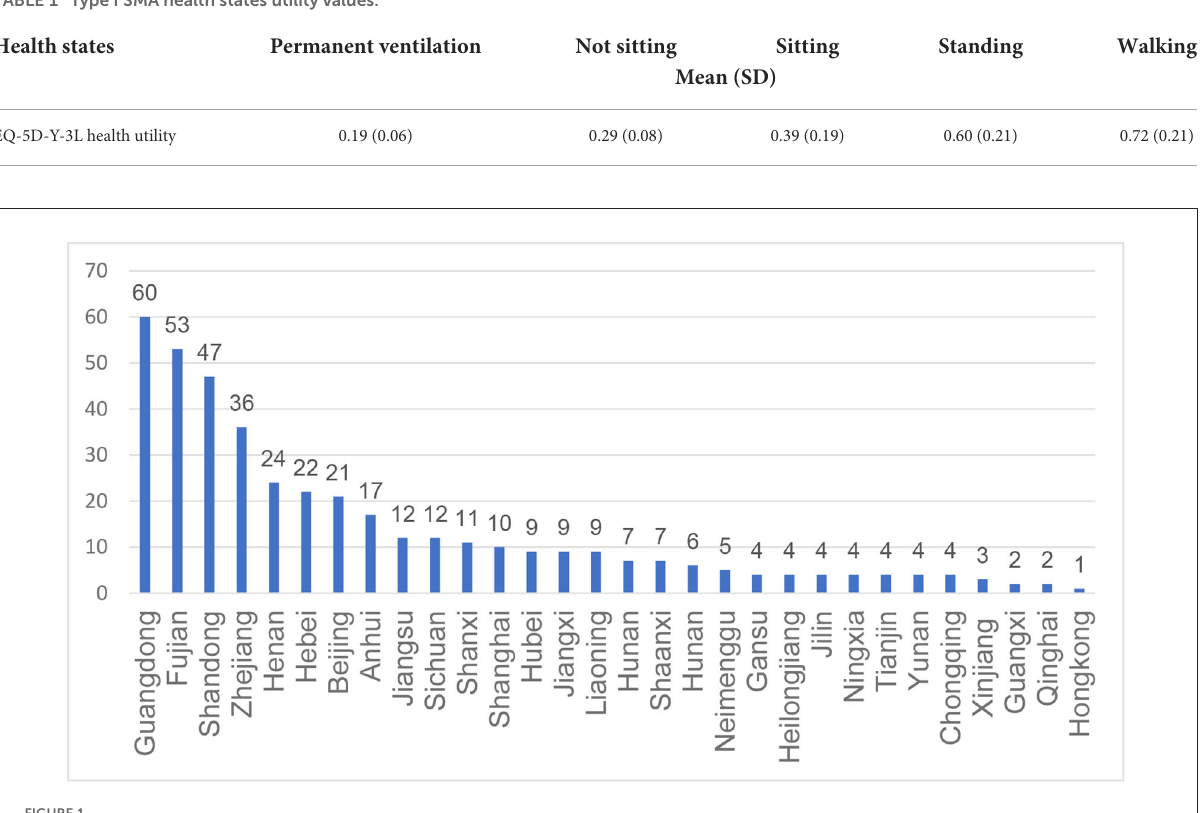
FIGURE1 Geographical distribution of participated SMA